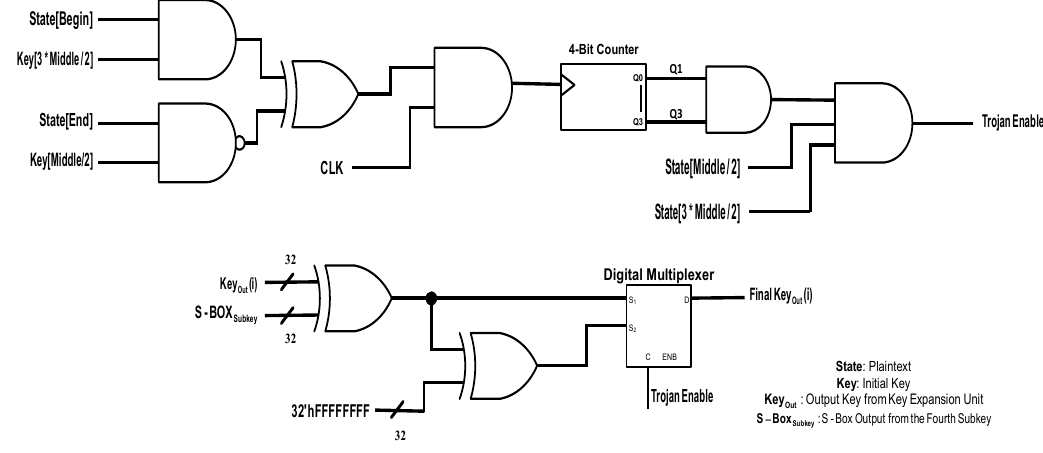
Figure 3. Attack 2: the Hardware Trojan circuit for malicious manipulation of the functionality of the key expansion